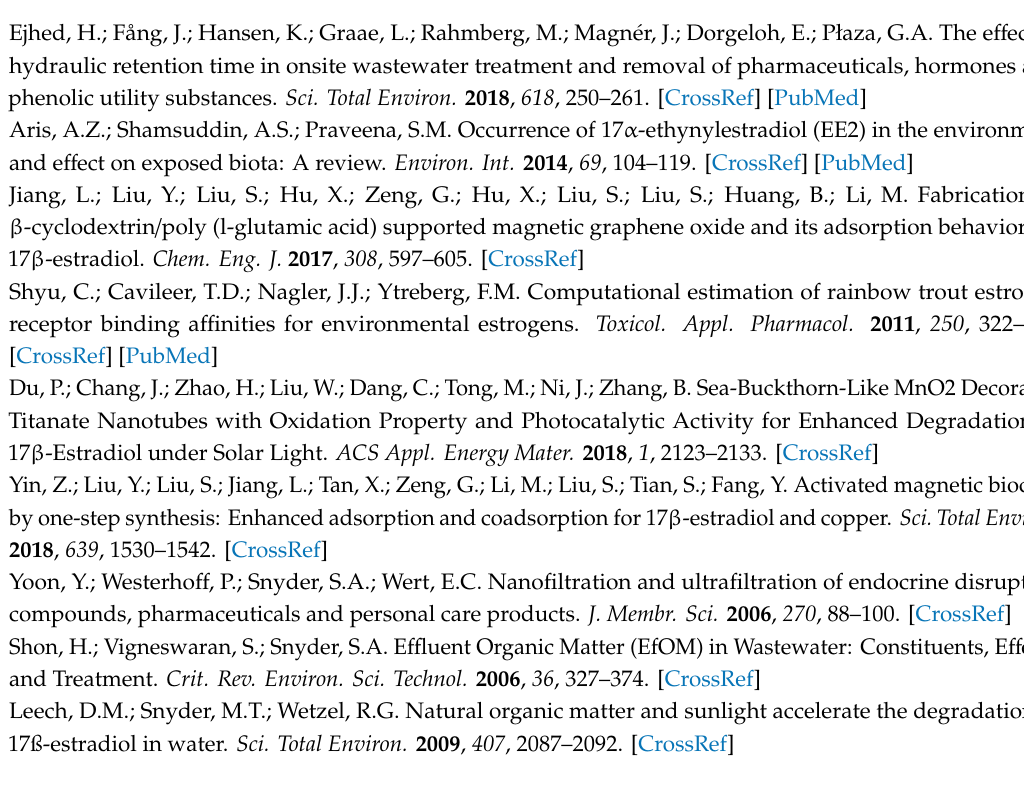
Figure S1. Optimized geometry coordinates and structure of E2, Table S1. Cartesian coordinates (Angstroms), Table S2. Salient physical parameters of TNTs, AC, and TNTs@AC, Table S3. Parameters of pseudo-first-order and pseudo-second-order kinetic models for E2 adsorption onto